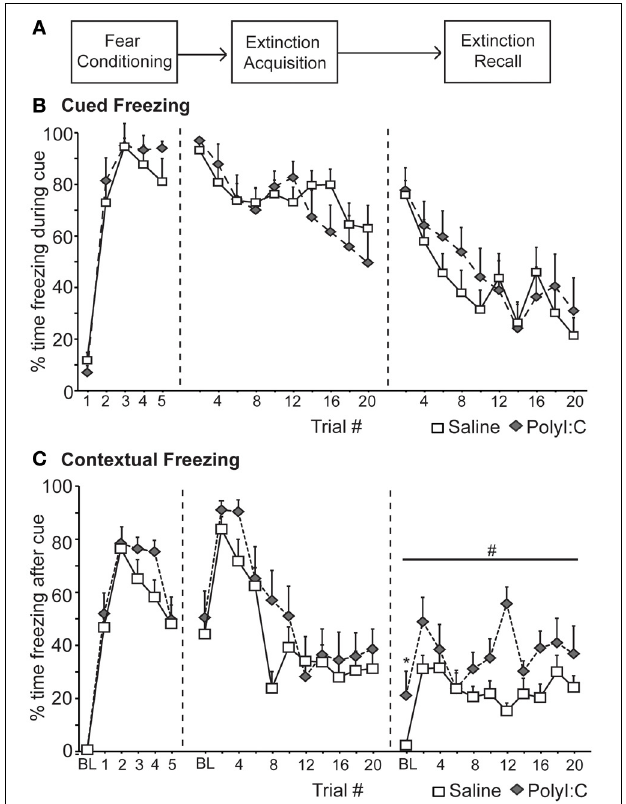
FIGURE 2 | Deficits in the recall of fear extinction for context in the offspring of rats treated with polyI:C during pregnancy (saline, n = 14 from 7 dams; polyI:C, n = 10 from 5 dams). (A) Schematic of experimental design. During Fear Conditioning rats received 5 tone-shock pairings. One day later (Extinction acquisition), the fear cue was presented 20 times without shock in the training context. This was repeated the next day (Extinction recall). (B) Cued Freezing. Percent time freezing during blocks of 2 fear cues is shown for each phase of the experiment. No differences between groups were detected. (C) Contextual Freezing. Percent time freezing during the 180s interval after blocks of 2 trials is shown for each phase of the experiment. Also included is the percent time freezing during the 180s prior to the first cue presentation (baseline, BL). The offspring of polyI:C-treated rats showed higher contextual freezing during Extinction #2 during BL ( ∗ p < 0 . 05) and the intervals between the cue presentations (# p < 0 .